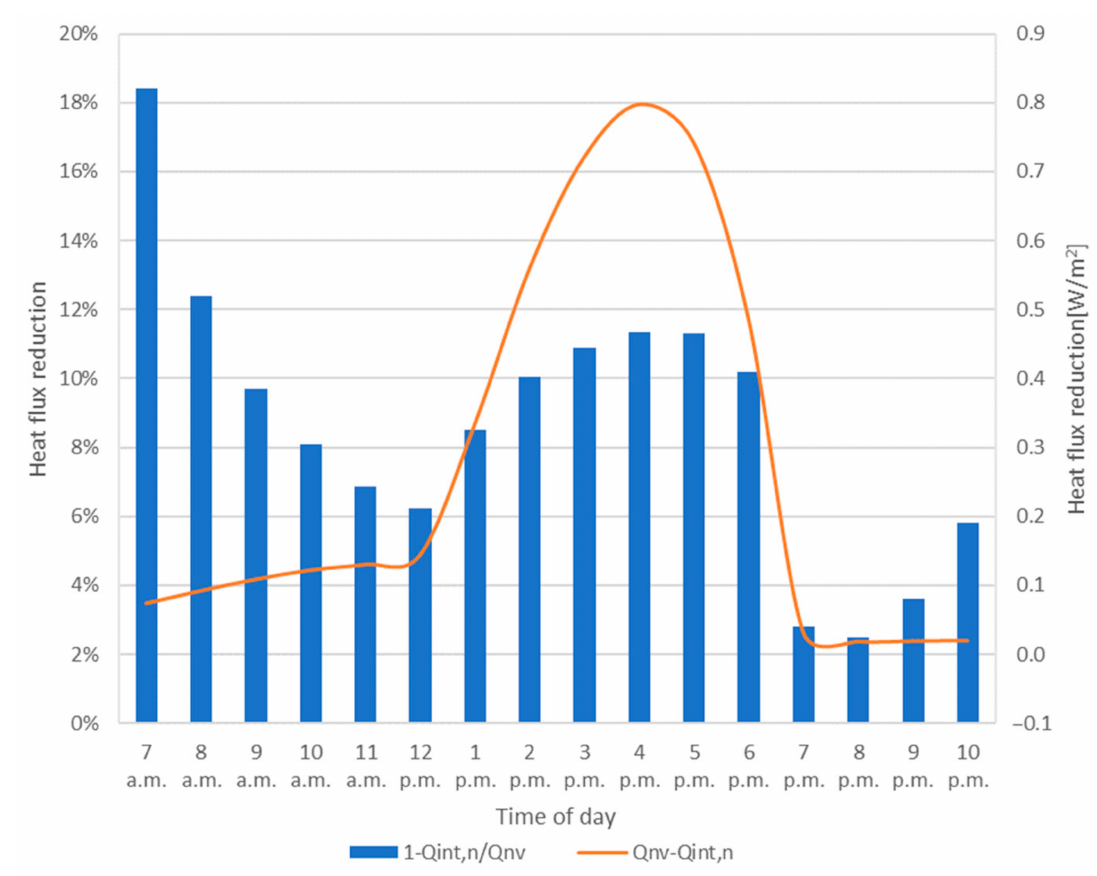
Figure 18. Hourly average energy saving (S i ) that could be reached using naturally ventilated façade instead of the unventilated one (the chart shows the average Si values along the façade